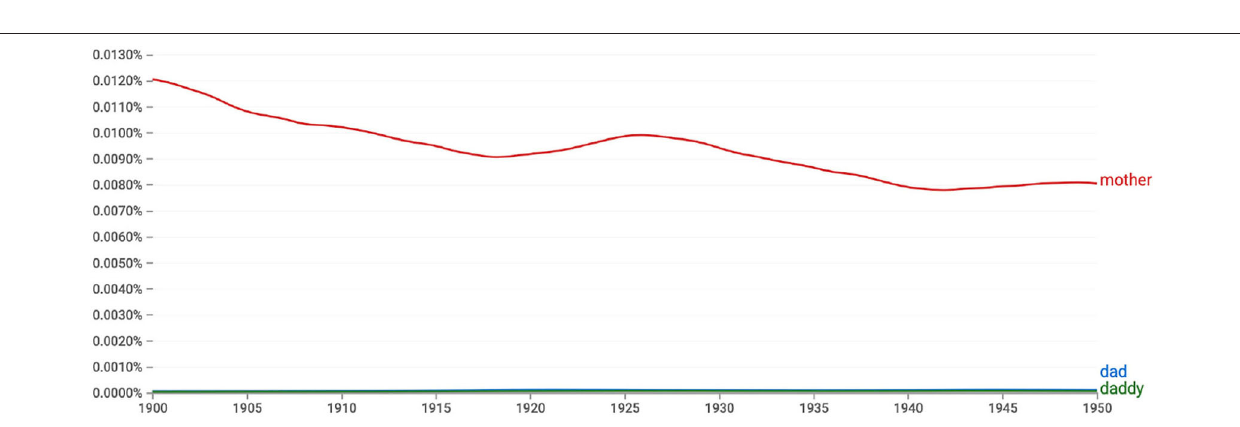
More generally, as we detail, the root cause of mother and daddy ’s order and the gradual shift among many other gendered binomials and the ordering of conventional